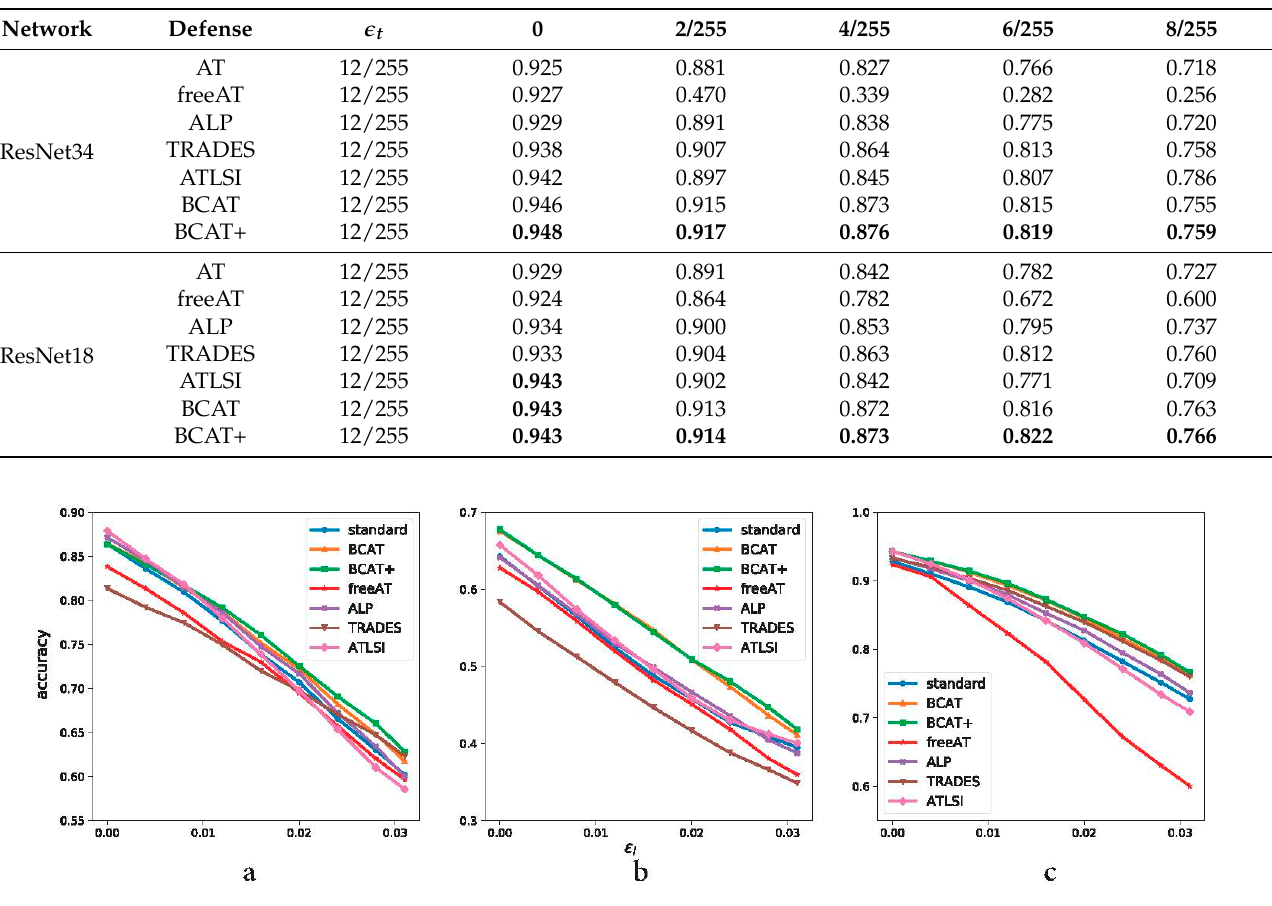
Figure 8. Robustness generalization curves of different defense methods on CIFAR-10, CIFAR-100, and SVHN. ResNet34, WRN34–5, and ResNet18 are used for CIFAR-10, CIFAR-100, and SVHN, respectively. ( a ) CIFAR-10. ( b ) CIFAR-100. ( c ) SVHN. CIFAR-10 Results on CIFAR-10 are exhibited in Table 1 and Figure 8a. For the sake of simplicity, the results under only four representative perturbation values of 2/255, 4/255, 6/255, and 8/255 are listed in Table 1. As shown in Table 1, for the ResNet34 network, BCAT+ achieves the highest robustness generalization accuracy among the evaluated defense methods at all chosen perturbation values except for the perturbation value of 2/255, where ATLSI slightly outperforms BCAT+ (0.818 vs. 0.817). The robustness generalization accuracy of BCAT ranks second at the perturbation values of 4/255 and 6/255; at the local perturbation values of 2/255 and 8/255,